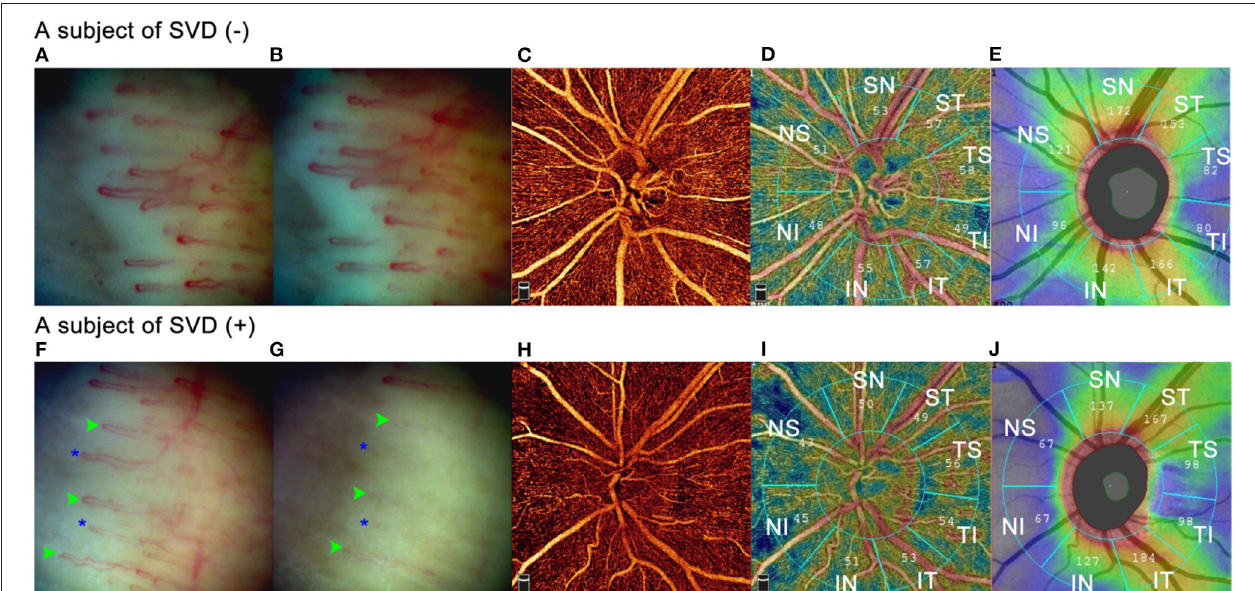
FIGURE 5 | Comparisons of nailfold capillary cold provocation test and OCTA between subjects with and without SVD. Two subjects were illustrated in Figure 5 . Image (A–E) were from a 34-year-old female without SVD. SBP/DBP was 118mmHg /81mmHg with a heart rate of 83 per minute. IOP was 15.9 mmHg. Image (F–J) were from a 42-year-old female with SVD. SBP/DBP was 127.5 mmHg/75 mmHg with a heart rate of 67 per minute. IOP was 15.2 mmHg. (A) and (F) showed nailfold capillaries after immersion in warm water for 3 minutes. (B) and (G) illustrated nailfold capillaries after immersion of ice saline at − 5 ◦ C for 1 minute. No blood flow standstill was observed in the SVD (–) subject, whereas in the SVD ( + ) subject several capillaries showed blood cell standstill for 40 seconds (green arrowheads) and some capillaries disappeared (blue asterisks). (C) and (H) were RPC maps of OCTA. The SVD ( + ) subject showed sparser RPCs than the SVD (–) subject. (D) and (I) showed sectoral vessel density calculated by AngioVue software according to Garway-Heath partition. (E) and (J) illustrated sectoral RNFLT according to Garway-Heath partition. In the IN, NI, NS, and SN sectors, the SVD ( + ) subject had thinner RNFLT than the SVD (–) subject did, and the vessel density was lower